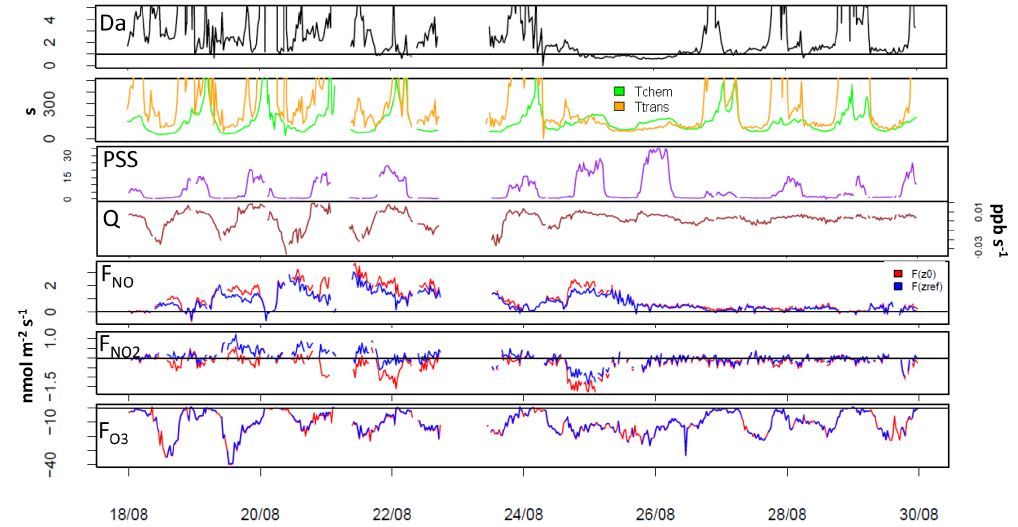
Figure 10. Half-hourly values of photo-stationary state ratio (PSS) and Q = k r [NO][O 3 ] − J NO timescales ( τ chem and τ trans ) and Damköhler number ( Da ); measured NO, NO 2 and O 3 fluxes and surface fluxes as computed by assuming a logarithmic flux divergence profile ( F NO , F NO